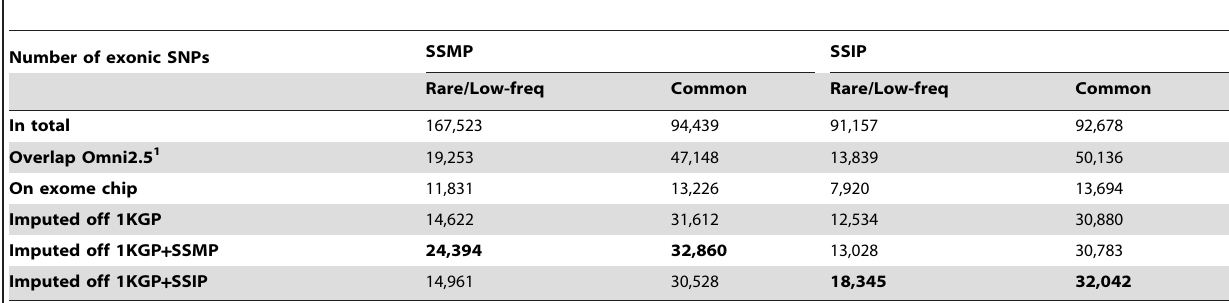
Table 3. Actual and recoverable content of exonic variants in 96 Malays (SSMP) and 36 Indians (SSIP) based on HumanOmni2.5 as the study